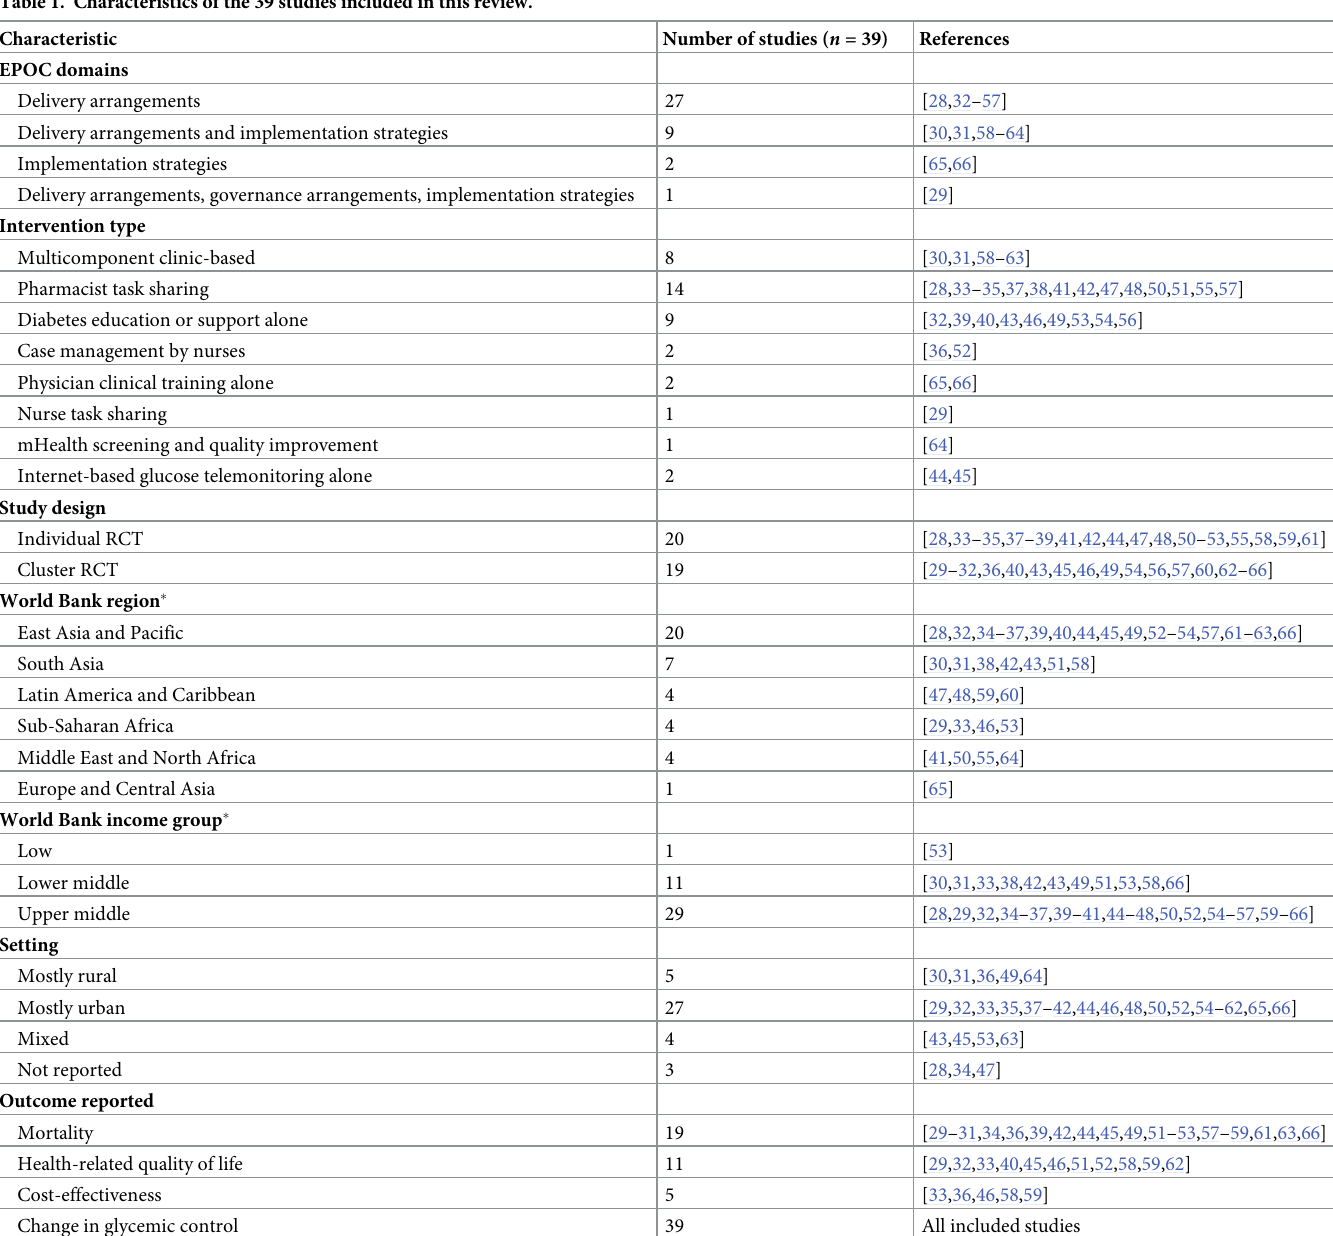
Table 1. Characteristics of the 39 studies included in this